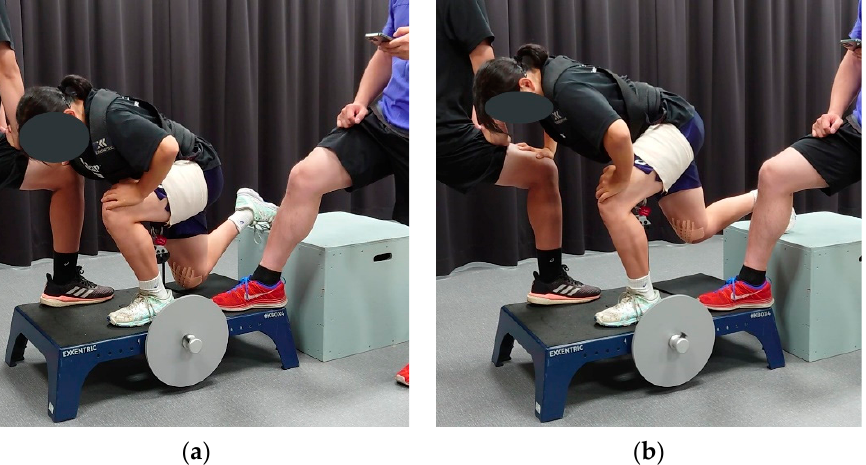
Figure 1. Setup for the Bulgarian split squat on the flywheel. ( a ) Starting/lowest position; ( b ) Highest position.